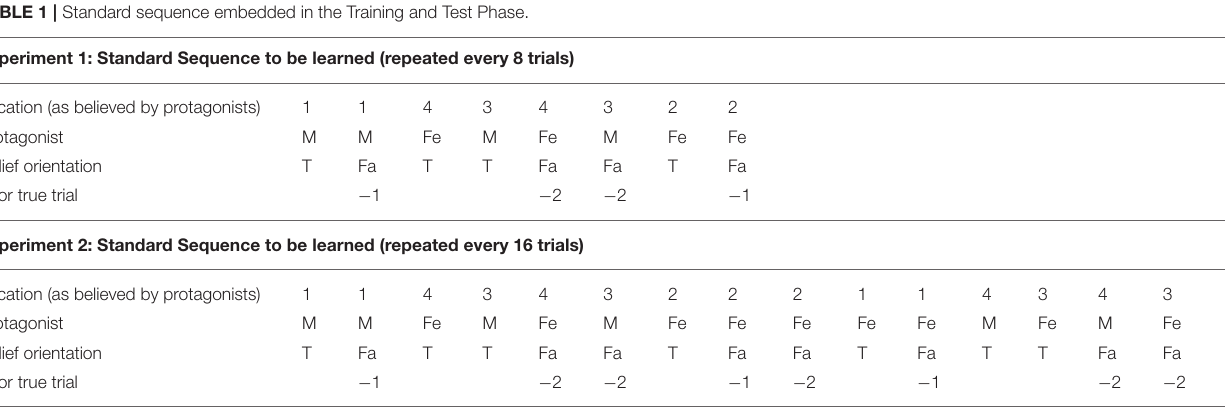
TABLE 1 | Standard sequence embedded in the Training and Test